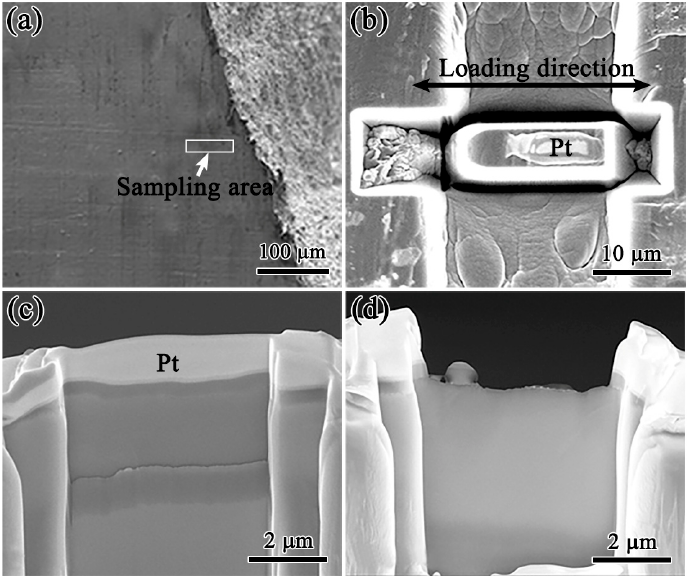
Figure 10. Preparation of TEM samples using FIB: ( a ) determination of cutting position, ( b ) sample cutting, and ( c , d ) sample reduction.